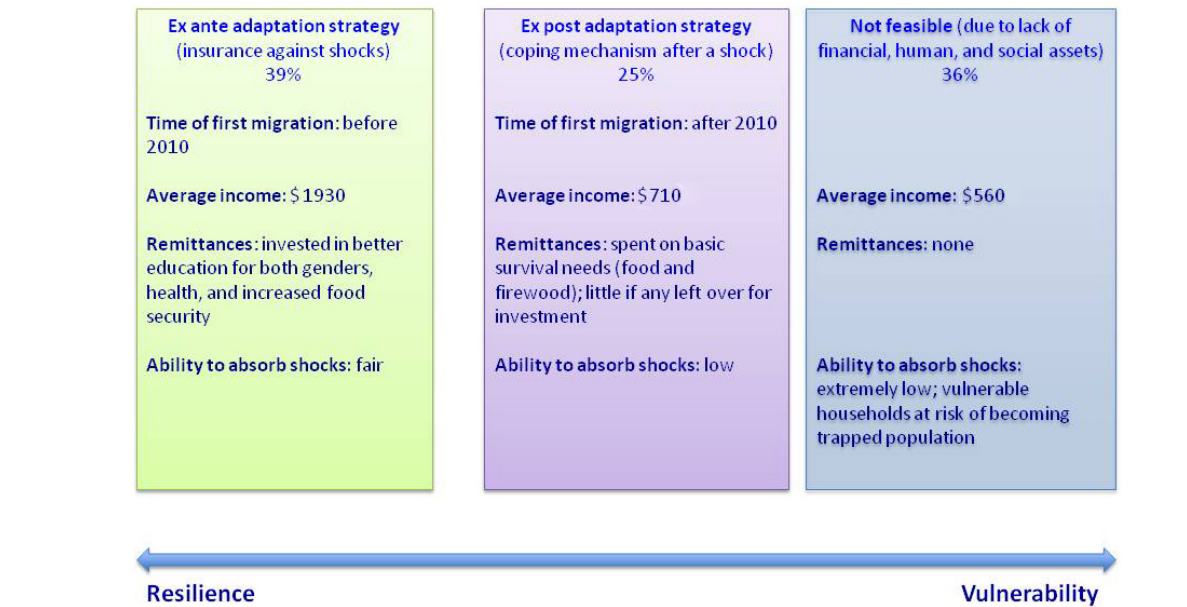
Figure 4. Household profiles highlighting the role of migration in households deprived of all or most arable land after the 2010 environmental shocks. Source: Gioli et al. (2014) (Fig.